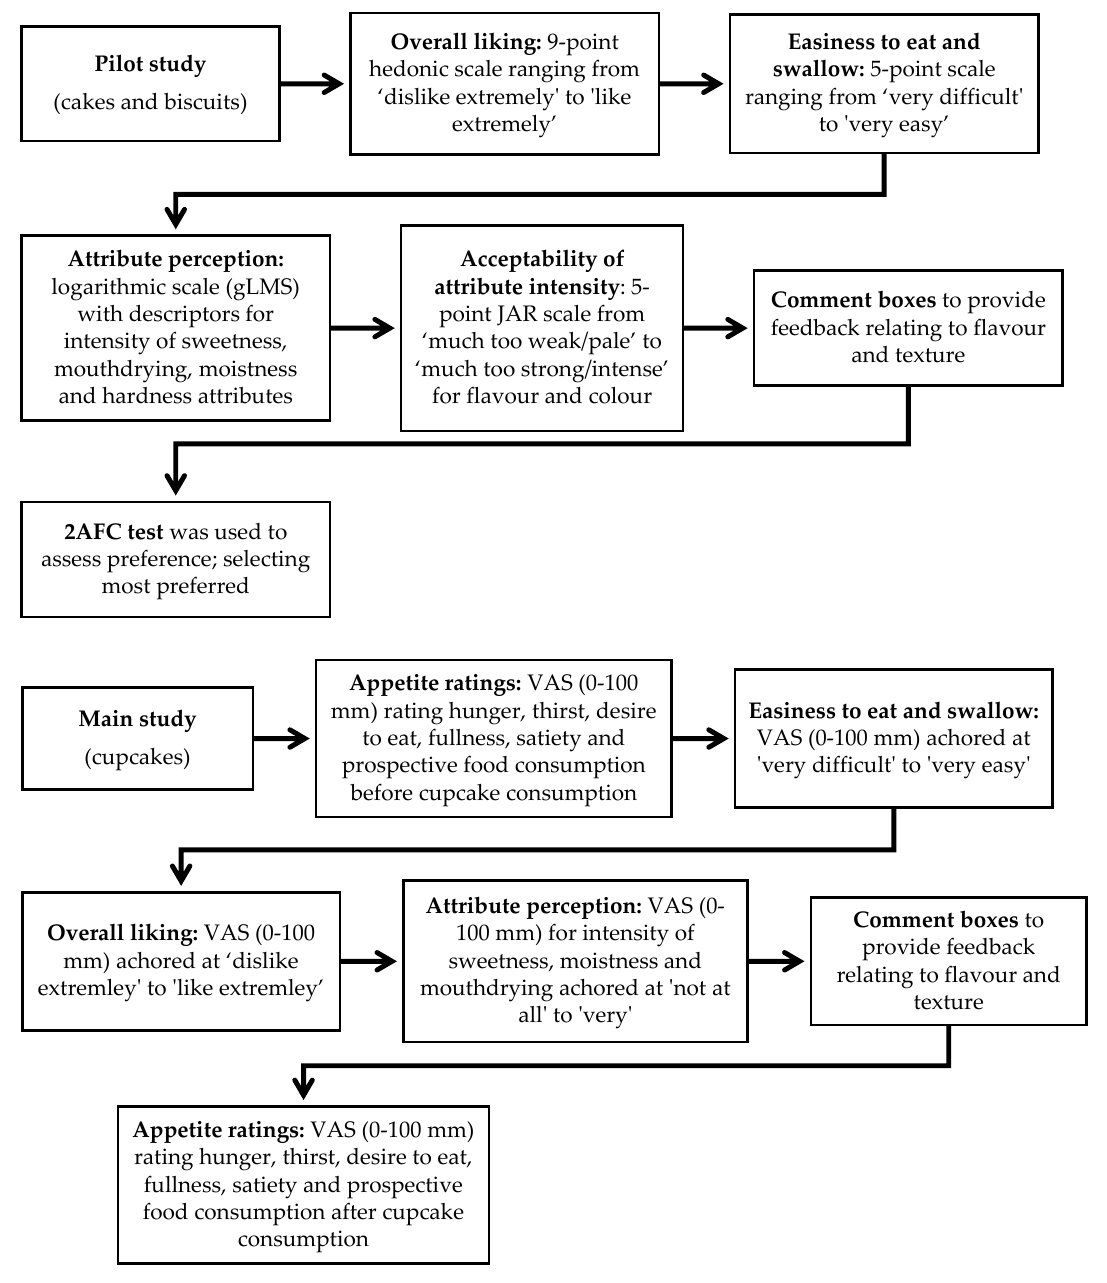
Figure 2. Overview of individual product perception and liking measures taken during both studies (GLMS: generalised Labelled Magnitude Scale; JAR: Just-About-Right; 2AFC: two alternative forced choice; VAS: visual analogue scale).